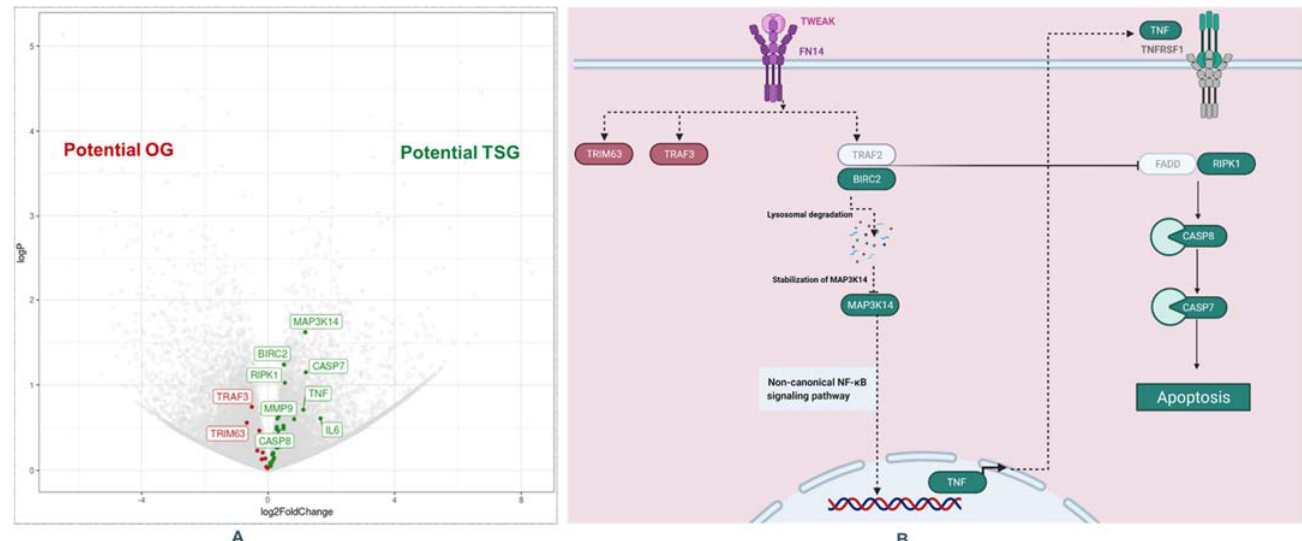
Figure 1. TNF-like weak inducer of apoptosis (TWEAK) Pathway in thick melanoma. ( A ): Volcano Plot for differentially gene expression: red boxes are genes with higher expression in thick M+ (left), and green boxes are genes with higher expression in thick M − (right). ( B ): Apoptosis module of the TWEAK pathway (Created with Biorender): Genes overexpressed in thick M − (green) and genes overexpressed in thick M+ (red), TWEAK/Fn14 interaction may trigger the degradation of cIAPs and then enhances apoptotic processes through TNFR1 [11–13]. This figure was adapted from Bhattacharjee et al. Abbreviations: OG: oncogene; TSG: tumor suppressor gene. Table 1. Clinical and histopathological parameters of all patients with thick CM.